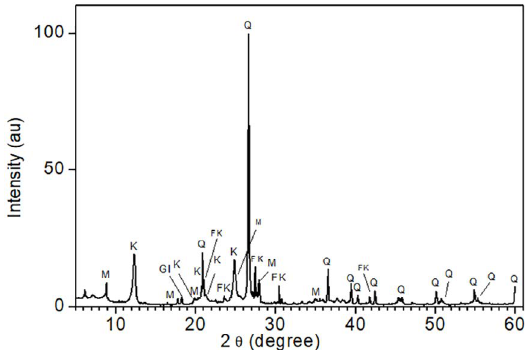
Figure 1. X-ray diffractogram of the ceramic clay. K= kaolinite; Gi = gibbsite; M = muscovite mica ; Q = quartz and FK= potassium feldspar.